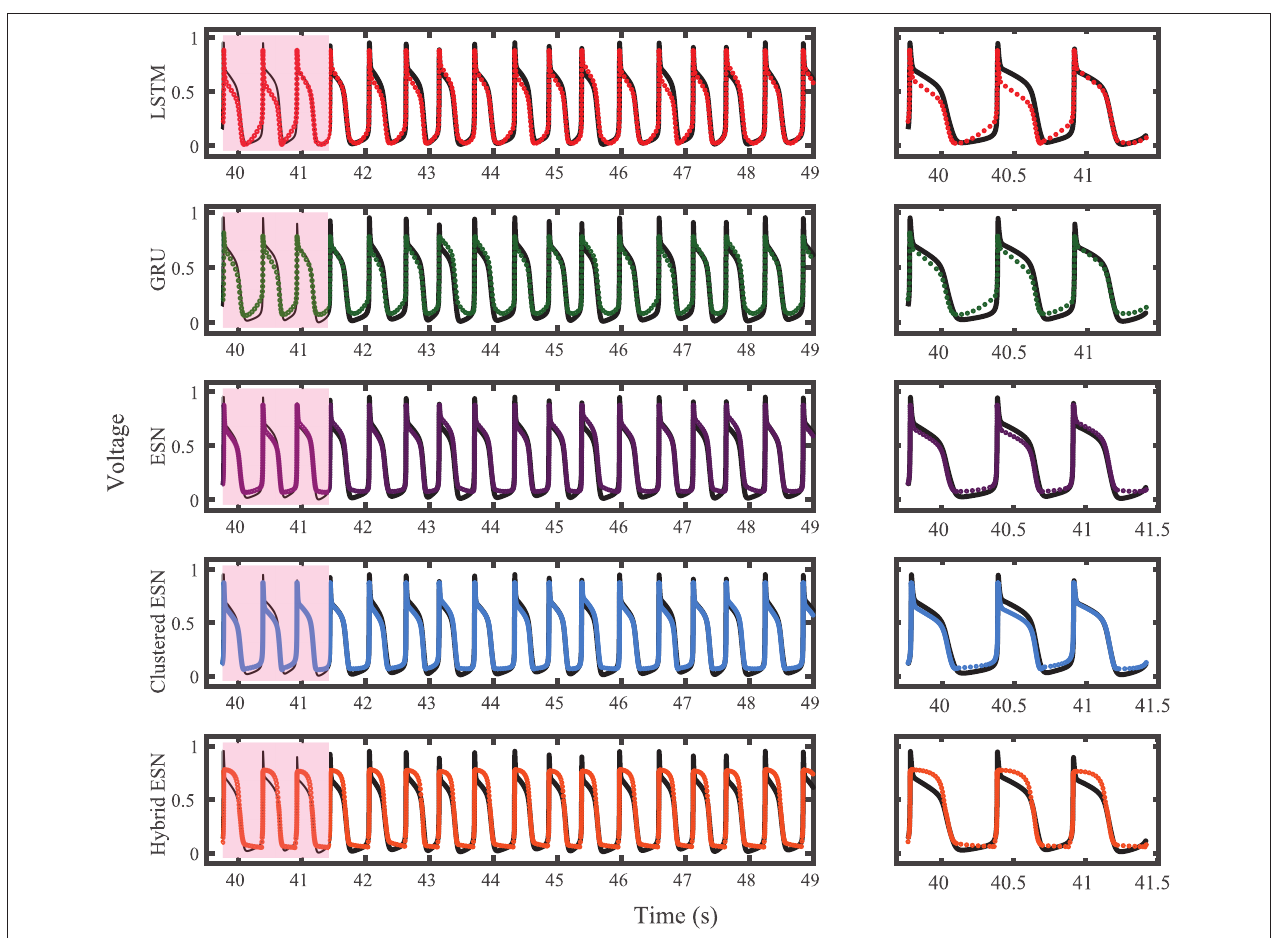
FIGURE 7 | Noble dataset action potential prediction results obtained for the five methods using a fixed network size of 100 neurons. Test data are shown in black for reference and the predictions in color. (Left) All predicted APs. (Right) Zoomed view of the first three predicted